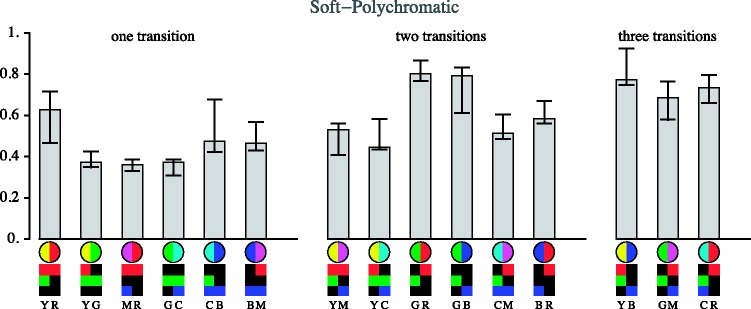
Normalised data for the soft polychromatic condition as quartiles over observers as bar plots for the various colour pairs. The transition structures are illustrated in Figures B1 and B2. The bars show quartile values of the distinctiveness settings for all observers.